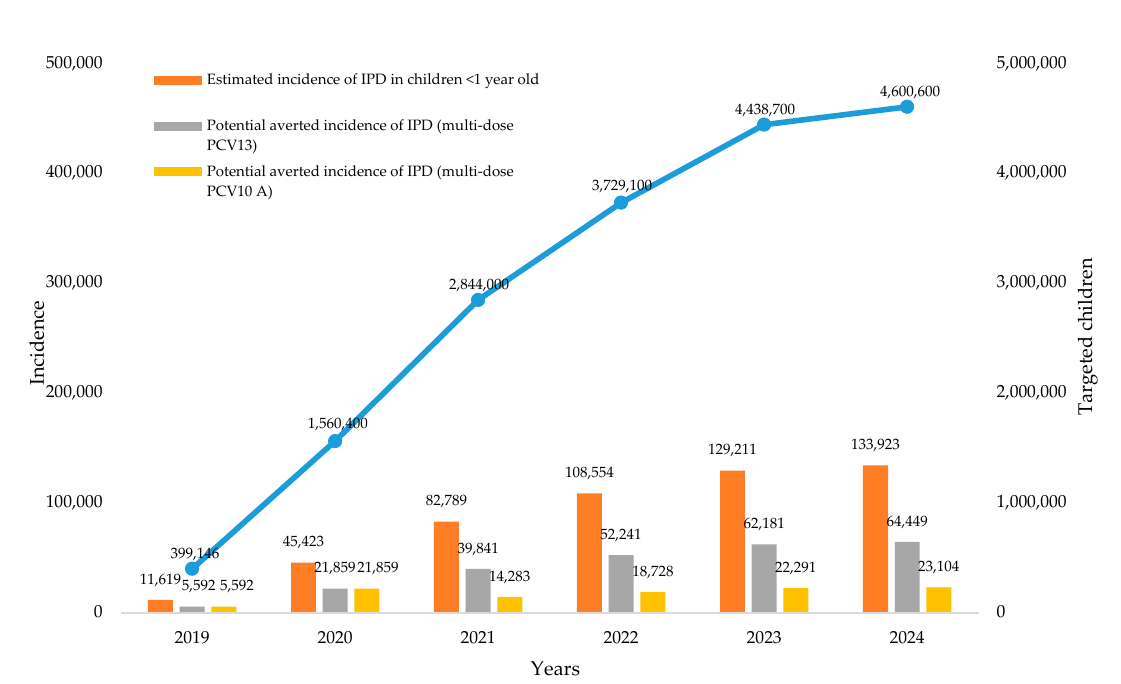
Figure 2. Potential averted incidence of invasive pneumococcal disease (IPD, children < 1 years old) in targeted regions in scenarios for multi-dose PCV13 and PCV10 A.